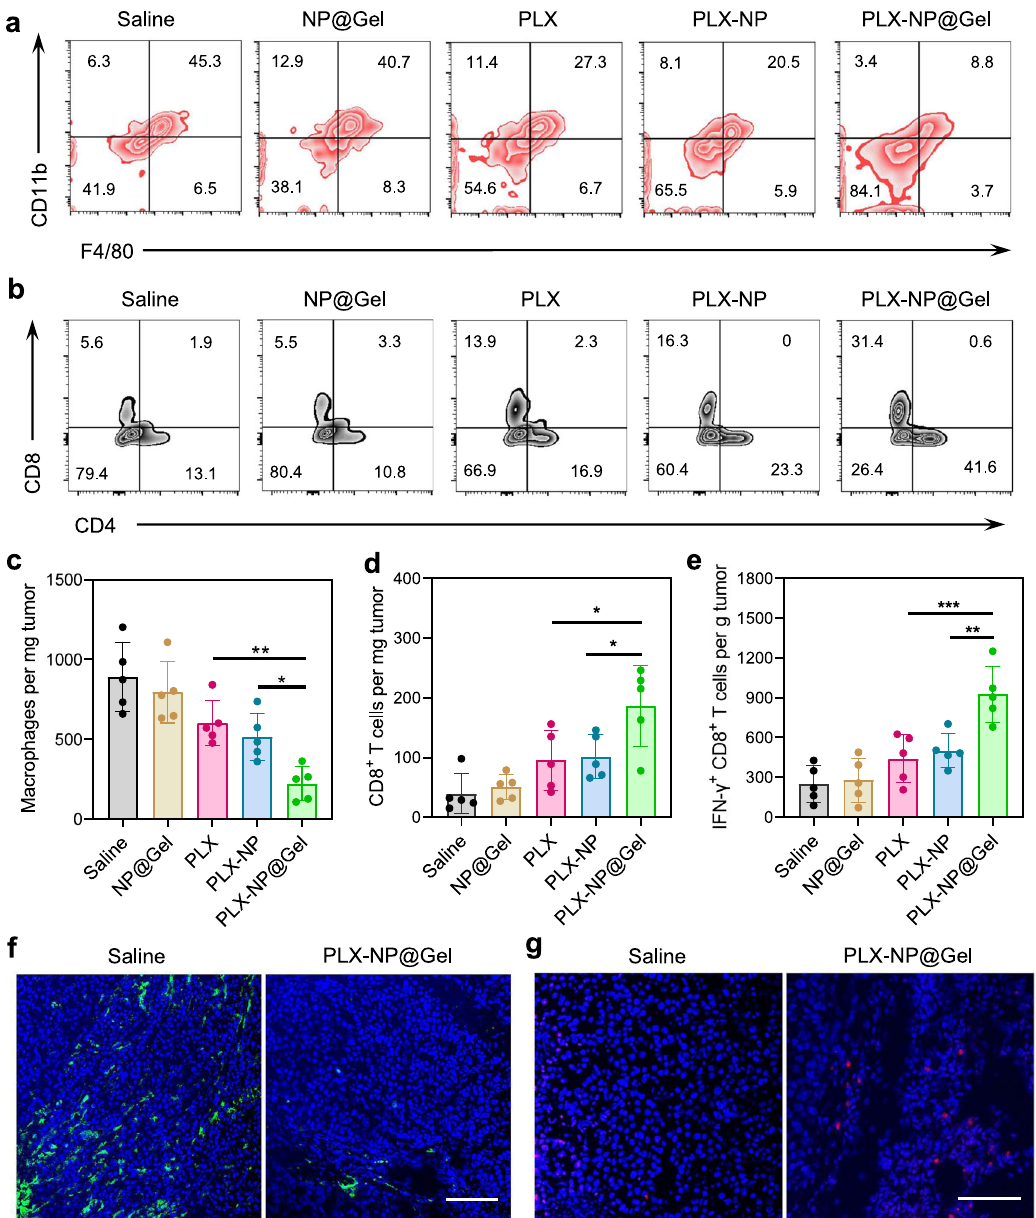
Fig. 2 Evaluation of in vivo TAM depletion and T cell in fi ltration after PLX-NP@Gel treatment in recurrent B16F10 tumor model. a , b Representative fl ow cytometry plots of TAMs ( a ) and CD8 + T cells ( b ) in the recurrent tumor tissues after treatments with saline, NP@Gel, PLX, PLX-NP, and PLX- NP@Gel. c – e Quantitative analysis of intratumoral densities of F4/80 + macrophages ( c , PLX-NP@Gel vs. PLX-NP: * P = 0.0358; PLX-NP@Gel vs. PLX: ** P = 0.0055), CD8 + T cells ( d , PLX-NP@Gel vs. PLX-NP: * P = 0.0242; PLX-NP@Gel vs. PLX: * P = 0.0147), and IFN γ + CD8 + T cells ( e , PLX-NP@Gel vs. PLX-NP: ** P = 0.0026; PLX-NP@Gel vs. PLX: *** P = 0.0007) per tumor mass in the recurrent tumor tissues after treatments with saline, NP@Gel,